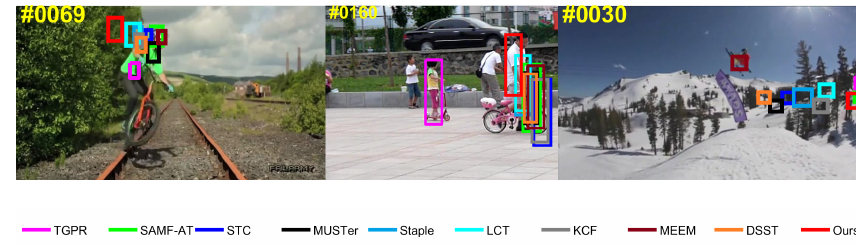
Figure 9. Failure cases on the OTB-2015 (from left to right: Biker , Girl2 , and Skiing ). In the Biker sequence, OV and LR are the most representative challenging attributes. The Girl2 sequence contains long-term occlusion tracking challenges. In the Skiing sequence, the target undergoes LR and IPR during